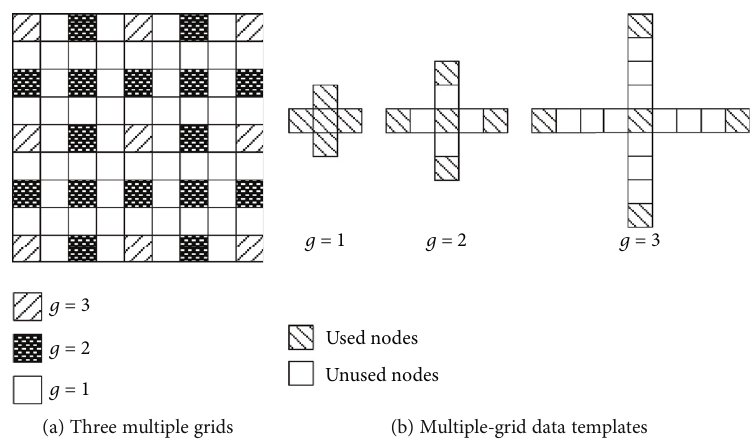
Figure 2: Example for multiple grids of three levels.